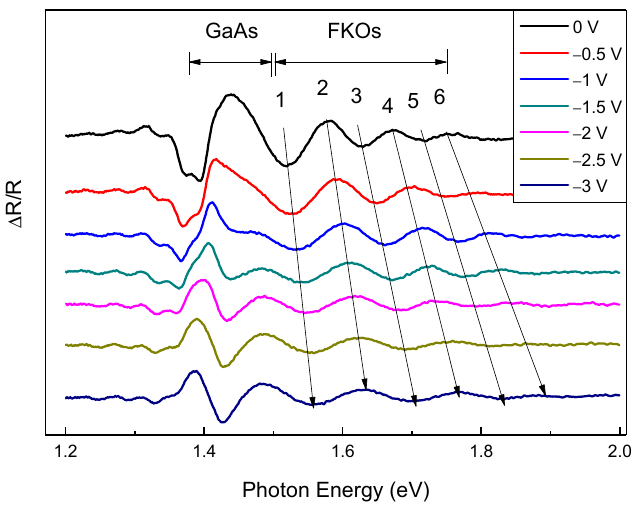
Figure 1. Electroreflectance spectra under different bias voltages.